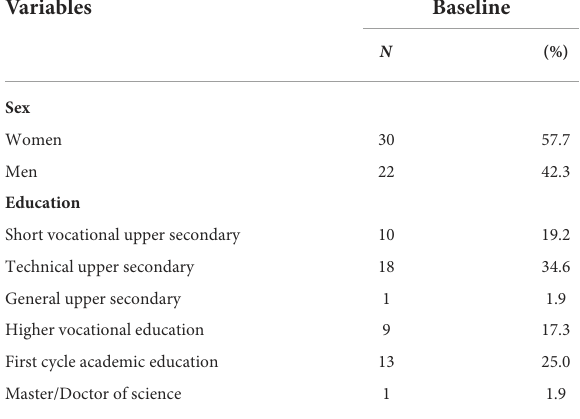
TABLE 1 Description of sex and education frequencies of